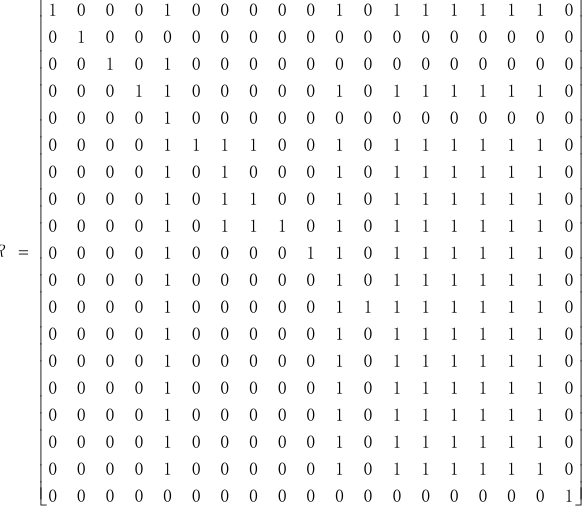
Table 4. Layer 1 partition of R .